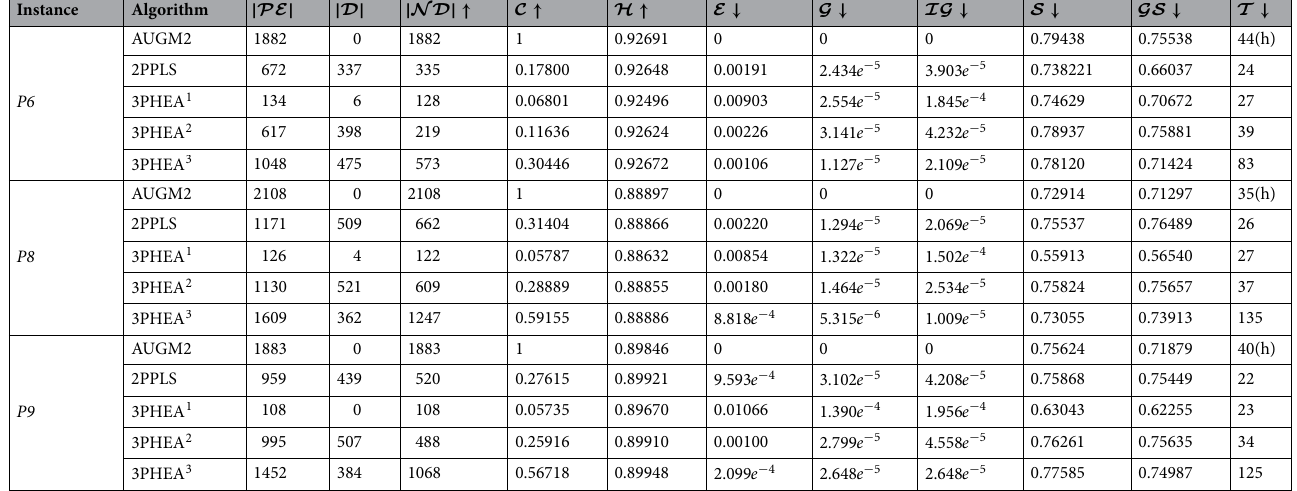
Table 7. Experimental results for datasets (Stützle and Paquete 61 ). | PE | : Number of potentially efficient solutions; | D | : Number of dominated solutions; | ND | : Number of nondominated solutions; C : Coverage metric; H : Hypervolume; E : Epsilon indicator; G : Generational distance; IG : Inverted generational distance; S : Spread; GS : Generalized Spread; T : Time in seconds unless